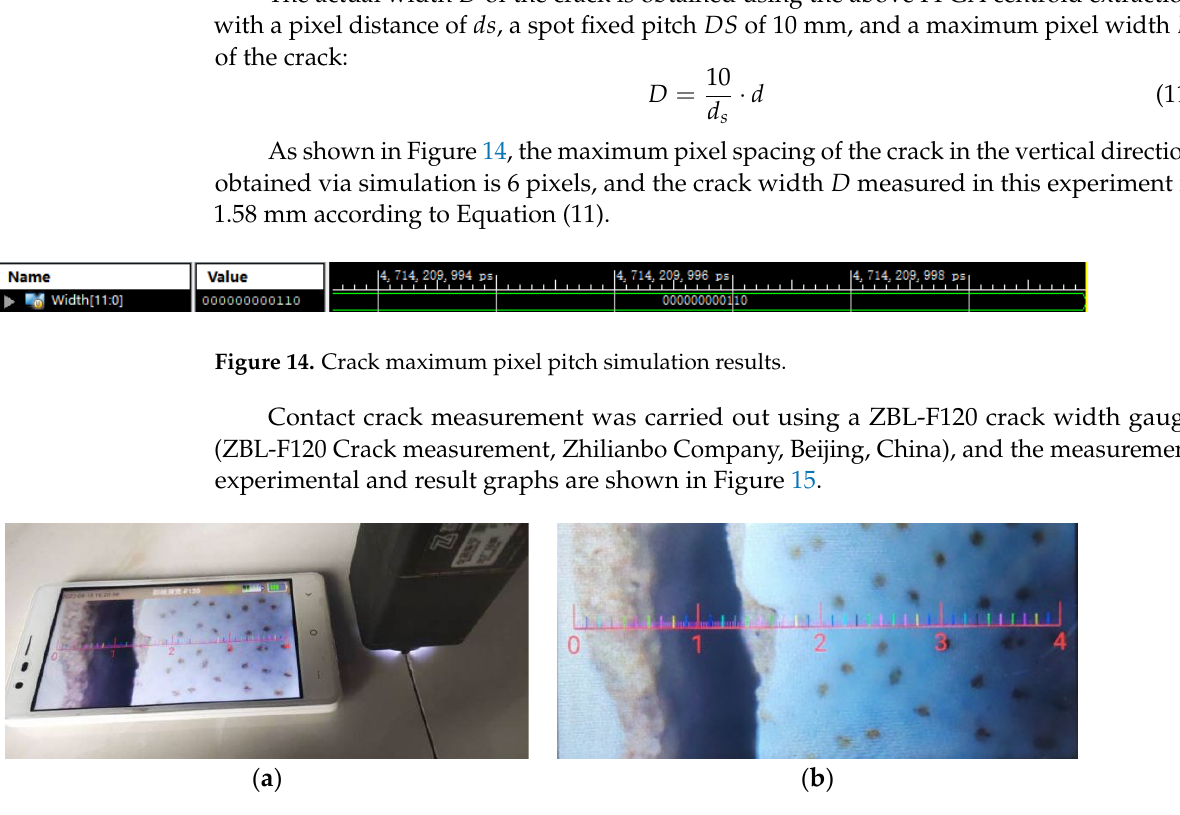
Figure 15. Experimental diagram of the crack with gauge measurements: ( a ) experimental operation graph; ( b ) experimental results graph.